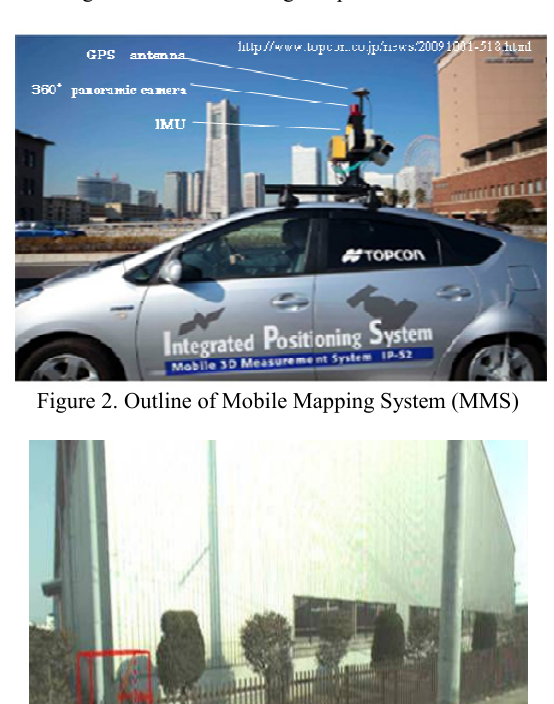
Figure 1. Tsunami damage map of Sendai Plain